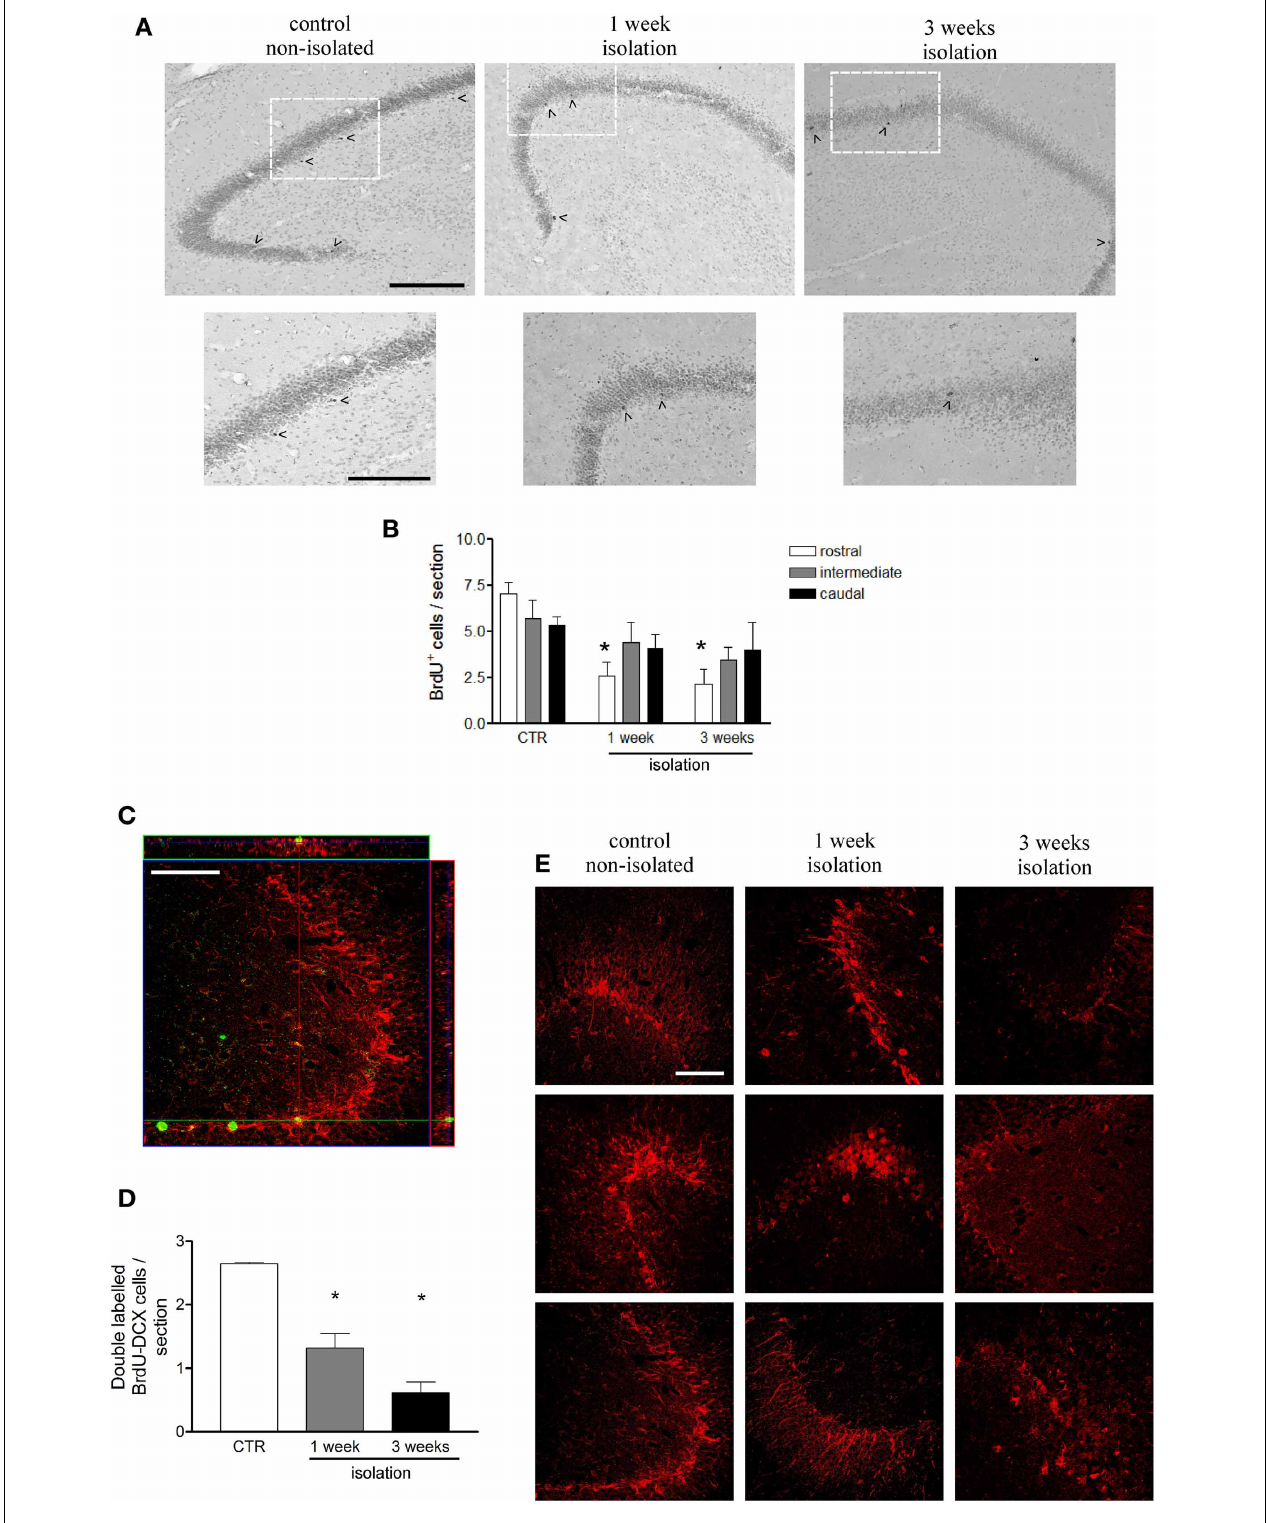
FIGURE 2 | Effects of social isolation on hippocampal cell proliferation. (A) Representative images of BrdU-positive cell labeling in dentate gyrus subgranular area in rostral region for each group in a wider view (upper panel) and in detail of the indicated area as showed in the lower panel; arrow heads